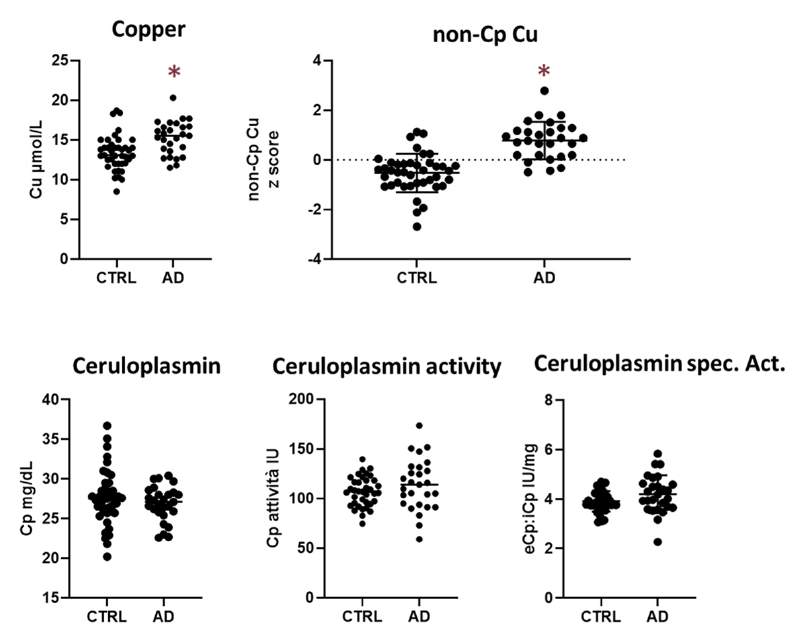
Figure 1. Comparison of the Cu panel between CTRL and AD subjects. Data are mean and standard deviation of Cu, non-Cp Cu, ceruloplasmin, ceruloplasmin, and ceruloplasmin-specific activity (* p < 0.05). Ceruloplasmin activity is additional quality control of ceruloplasmin measurement as extensively discussed elsewhere [11]. Ceruloplasmin-specific activity (eCp:iCp) is the enzymatic activity per mg of Cp concentration. Raw data are shown, not adjusted for subjects’ differences in sex and age. Table 3. Comparison of AD (non-Cp Cu < 1.6 µ mol/L) and CuAD (non-Cp Cu ≥ 1.6 µ Table 2. Comparison of the Cu panel between CTRL and AD subjects.